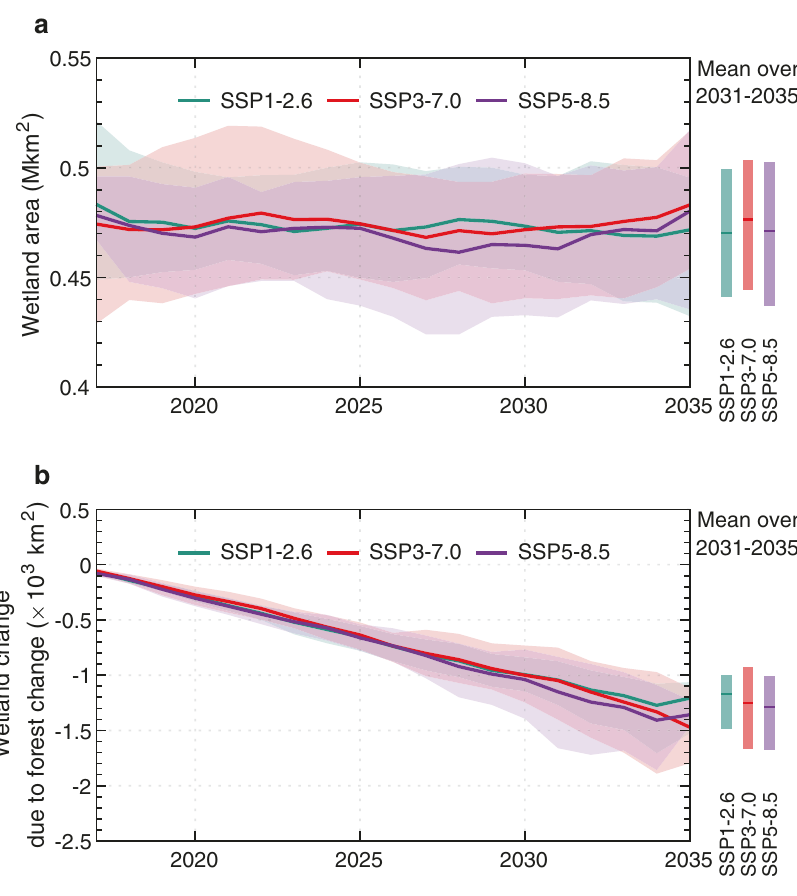
Fig. 6 Time series of wetland change due to near-term climate change and forest change in China. a Near-term wetland change under S B scenario (including climate change, elevated atmospheric CO 2 concentration, and forest change) under three shared socioeconomic pathways (SSPs) for 2017 – 2035 in China. b Near-term wetland change due to forest change under three SSPs for 2017 – 2035 in China. The solid lines show the multi-model mean projections (5-year moving average), and the shading presents the likely ranges estimated from the fi ve individual climate models. The time means for 2031 – 2035 are shown as colored vertical